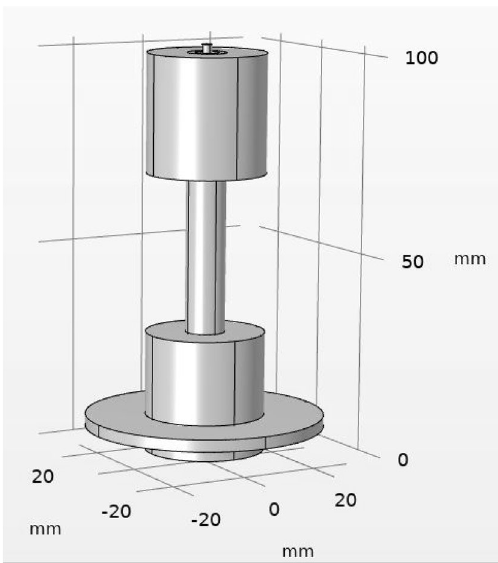
Figure 1. Three-D geometry of simulated JDBD (COMSOL